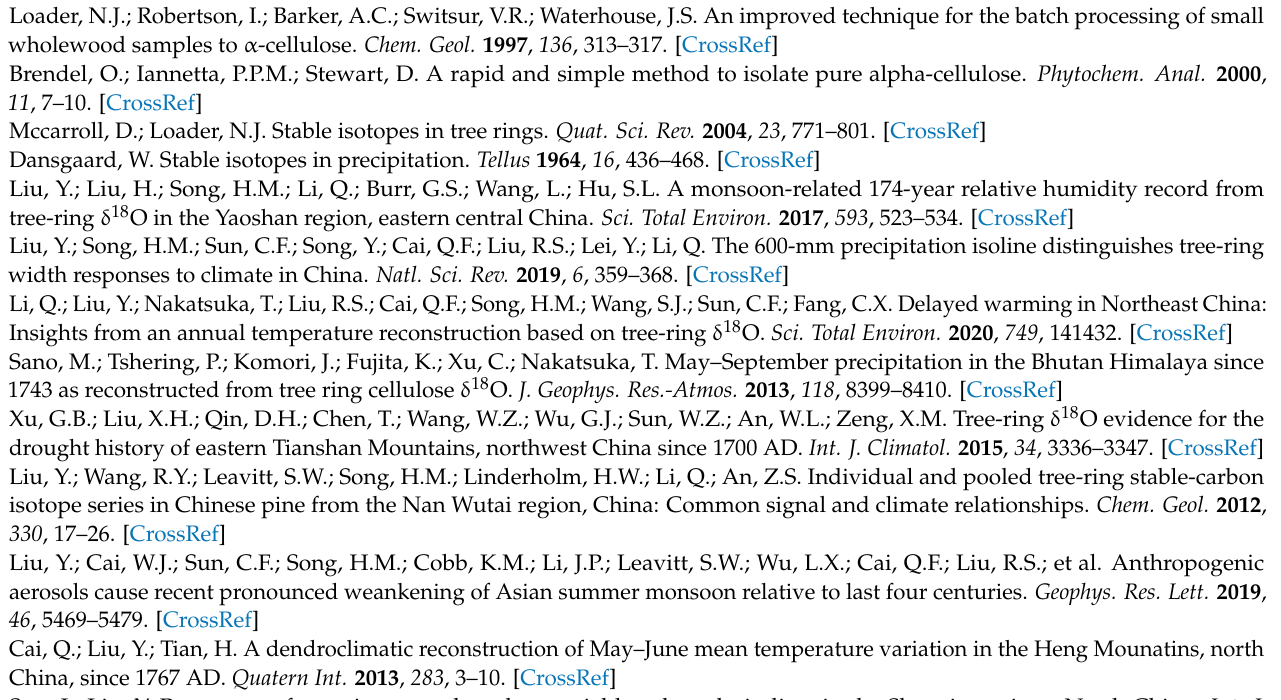
time series. Table S2: Correlation coefficients among individual tree ring δ 18 O series. Table S3: Statistical characteristics of composite δ 18 O chronology. Table S4: Calibration and verification statistics for the P J-J reconstruction in Heng Mountain. Table S5: Comparisons between the reconstructed precipitation and historical records. Table S6: Correlation between several Asian summer monsoon indices and the reconstructed